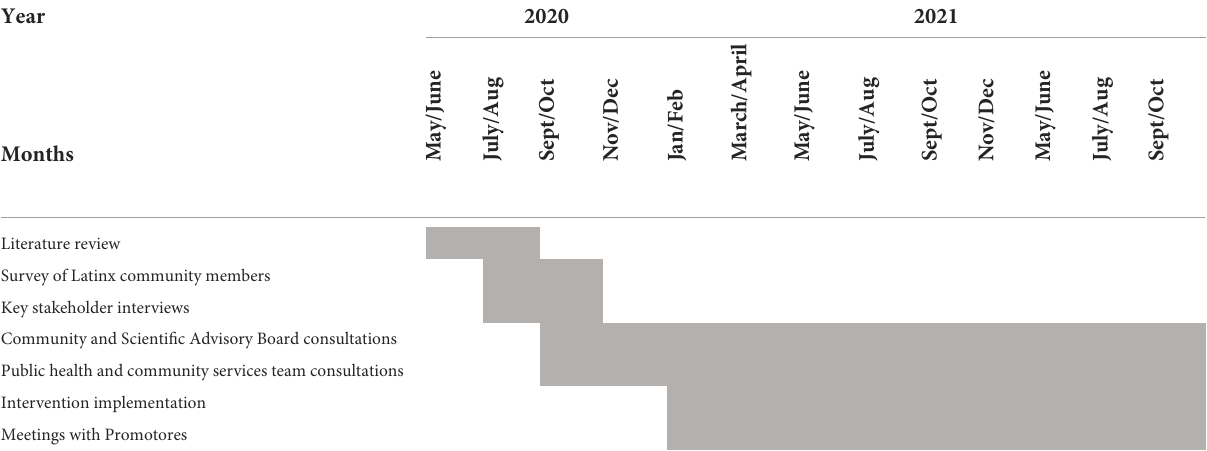
TABLE 1 Timeline of Promotores de Salud development and